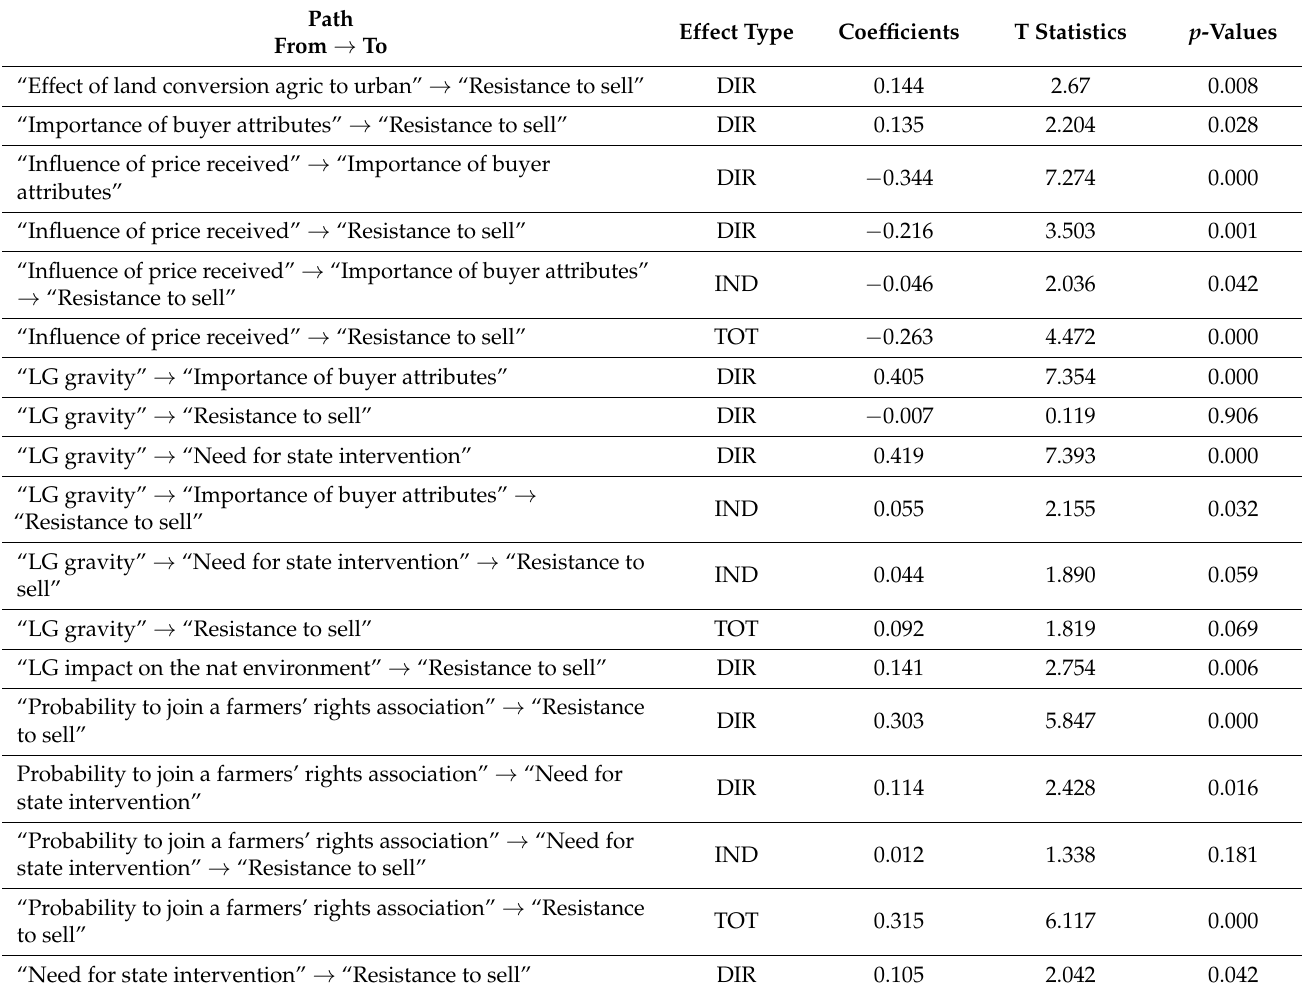
Table 5 showed the total effect, direct effect, and indirect effect of constructs. According to Table 5, the effect of “Perceived effect of agricultural land conversion to urban land” had a direct and significant positive effect on resistance to sell ( β = 0.144, sig. = 0.008). The “Importance of buyer attributes” had a positive and direct effect on resistance to sell ( β = 0.135, sig. = 0.028). Table 5. Total effects, direct effects, and indirect effects of the